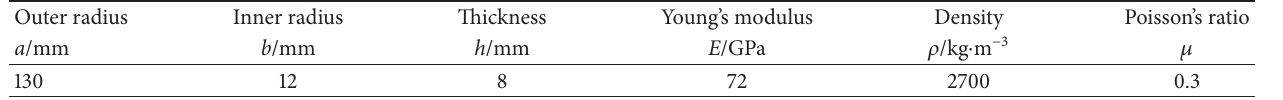
Table 4: Parameters of the distorted model.